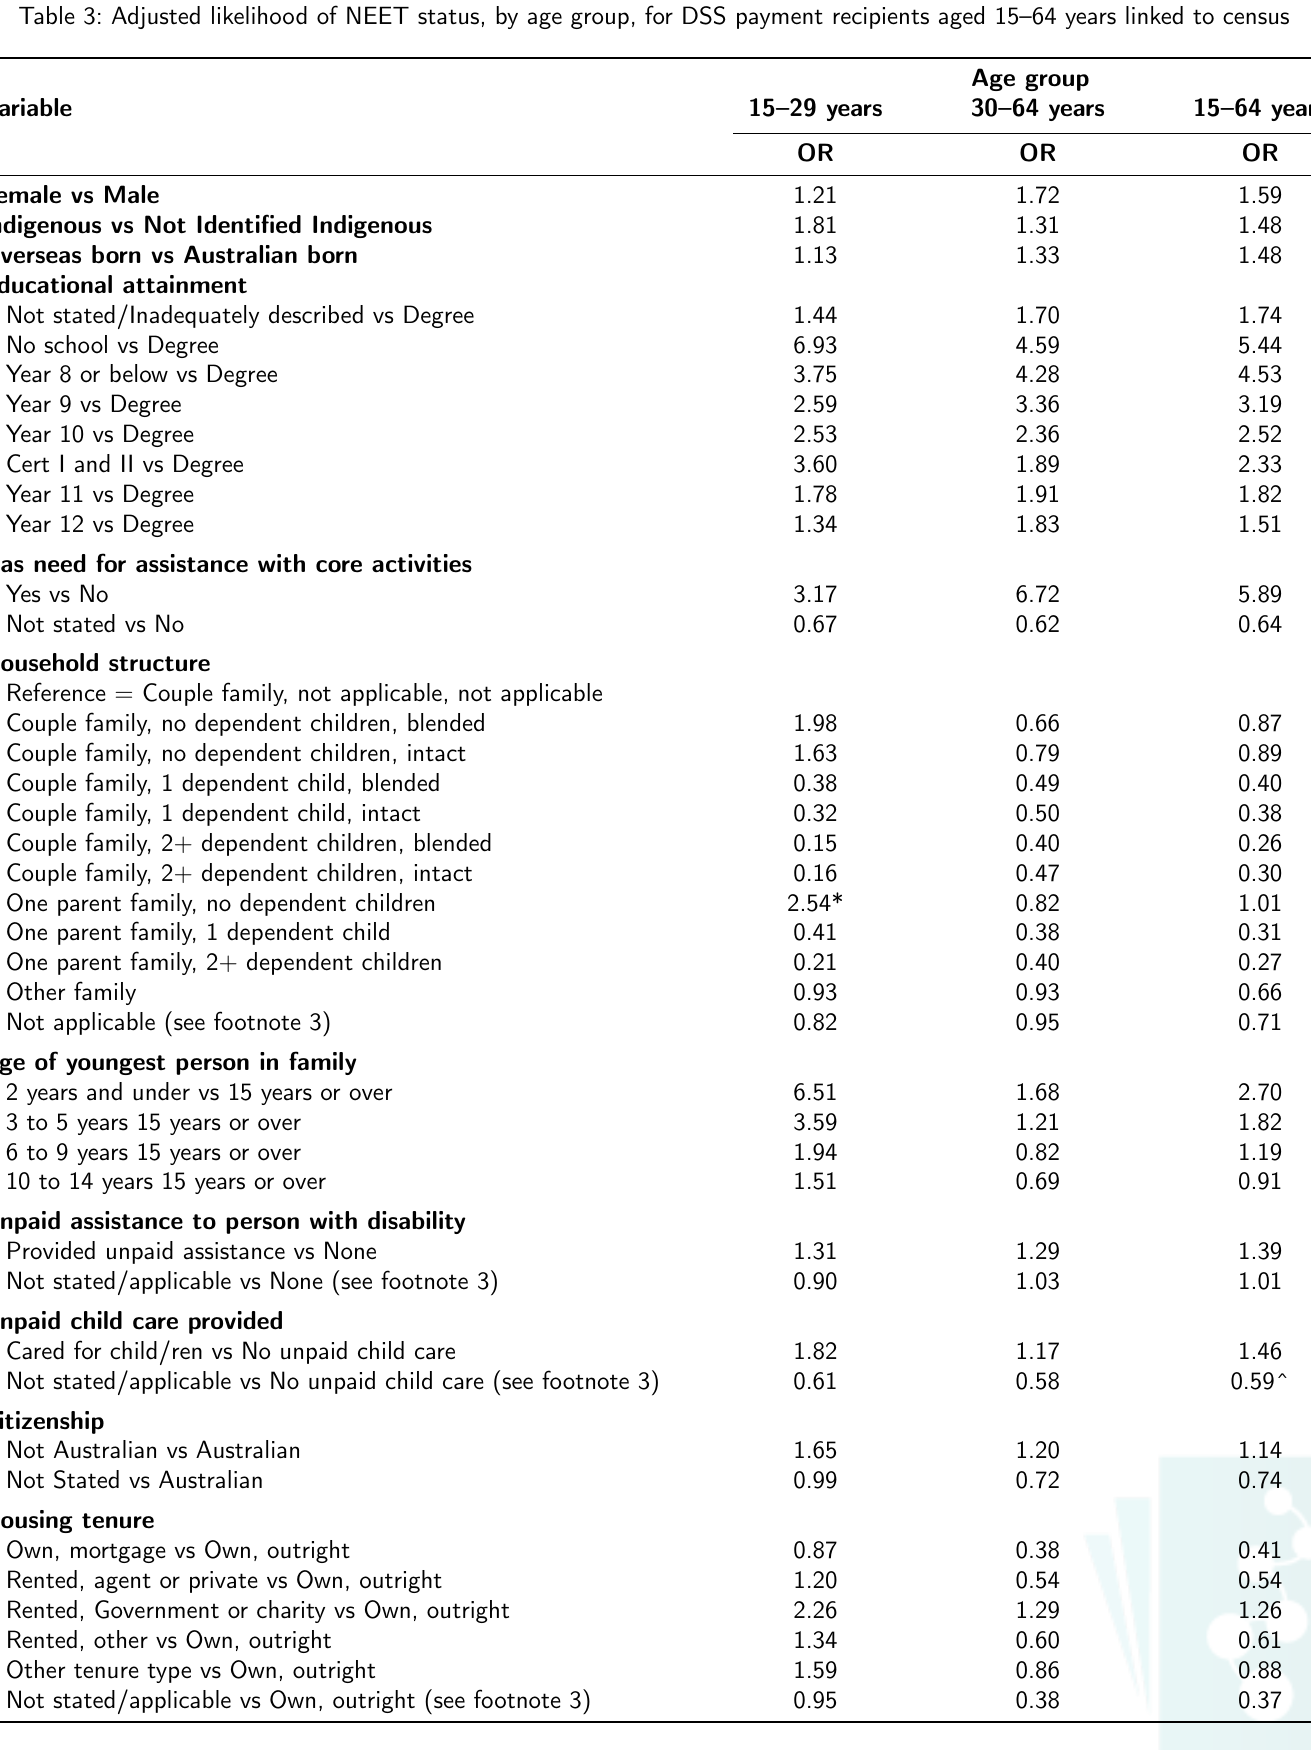
Table 3: Adjusted likelihood of NEET status, by age group, for DSS payment recipients aged 15–64 years linked to